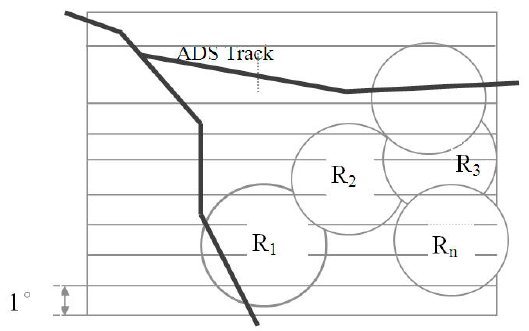
ffi c Management (ATM)